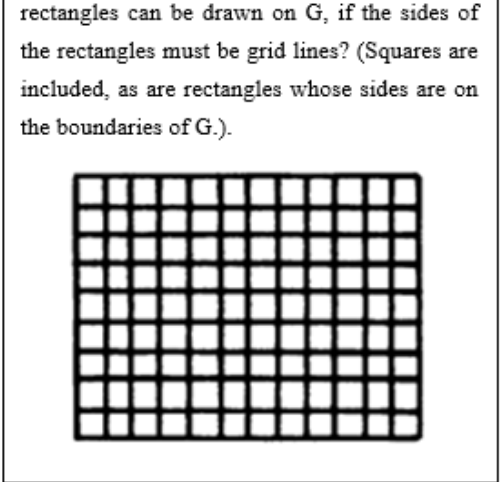
Table 1. Indicators of